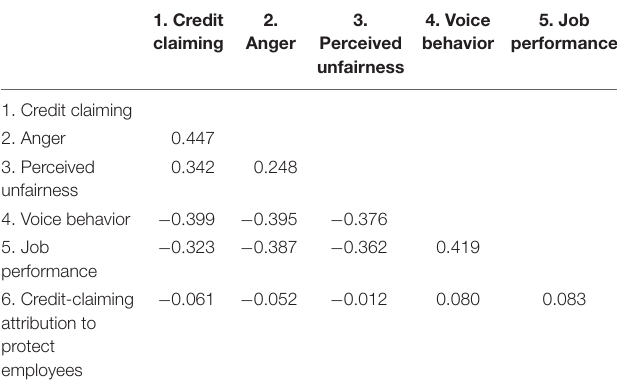
TABLE 3 | Correlations between two